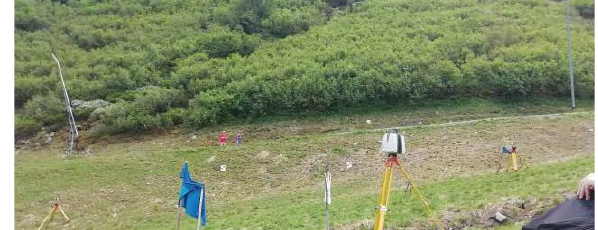
Figure 5. Scan location at Rumsoppen of the time series-based classification assignment. The location in the image is scanned 11 times at 10’ interval. Trees and a piece of cloth are expected to be moved by